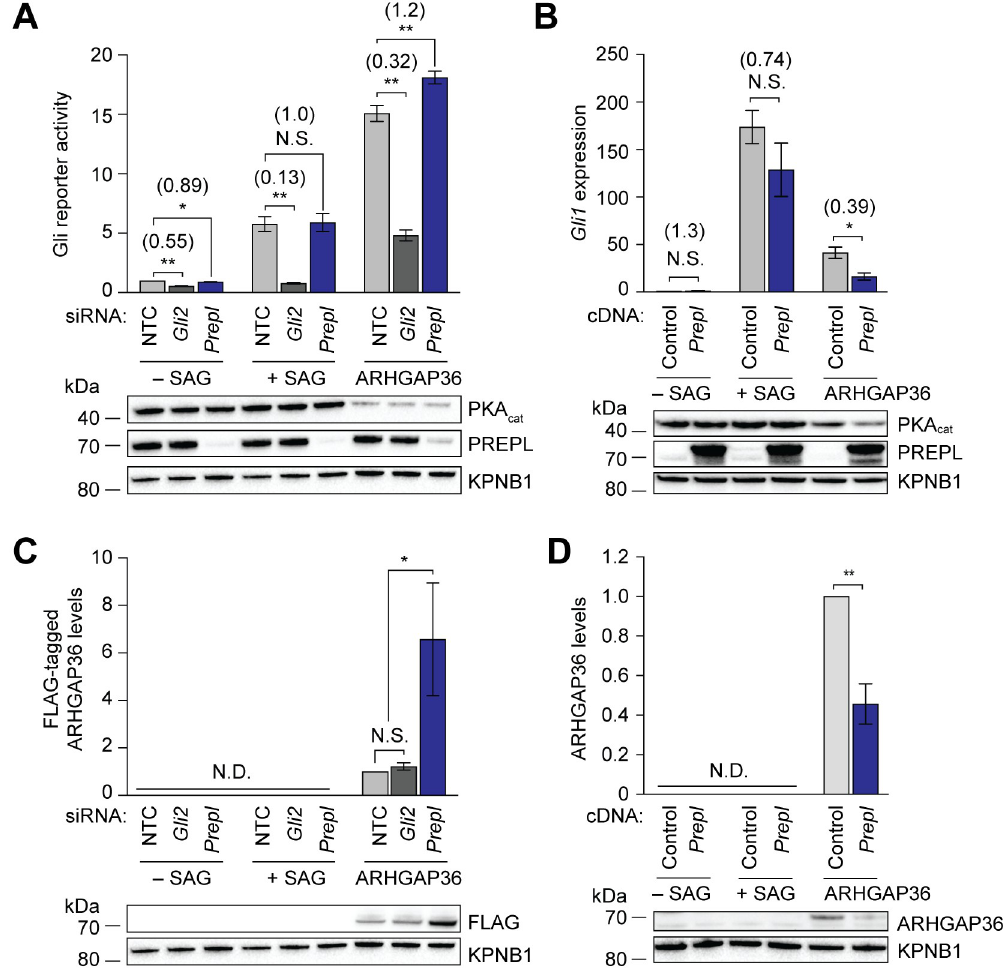
Fig 6. PREPL attenuates ARHGAP36-mediated Gli activation. (A and C) Effects of Prepl siRNAs on Gli-dependent luciferase reporter activity (A) and ARHGAP36 protein levels (C) in SHH-LIGHT2 cells stimulated with SAG or retrovirally transduced with FLAG-tagged ARHGAP36 isoform 2. SHH-LIGHT2 cells treated with either a non-targeting control siRNA (NTC) or Gli2 siRNA were included as controls. Data are the average fold change relative to NTC siRNA-transfected, untransduced cells for six biological replicates ± s.e.m. (A) or ARHGAP36-expressing cells for five biological replicates ± s.e. m. (C). (B and D) Effects of exogenous Prepl expression on Gli1 transcription (B) and ARHGAP36 protein levels (D) in NIH- 3T3 cells stimulated with SAG or transduced with FLAG-tagged ARHGAP36 isoform 2. Cells transduced with 3xFLAG-ires- mCherry vector were included as negative controls. Data are the average fold change relative to control vector-transduced, unstimulated cells (B) or ARHGAP36-expressing cells (D) for three biological replicates ± s.e.m. Values in parentheses represent the fold change relative to cells transfected with NTC siRNA (A) or transduced with control vector (B) within the same treatment group. Single and double asterisks indicate P < 0.05 and P < 0.01, respectively, and N.S. indicates P � 0.05. N.D. indicates a lack of detected signal. Representative western blots for each condition are shown, with the importin β 1 subunit (KPNB1) used as a loading